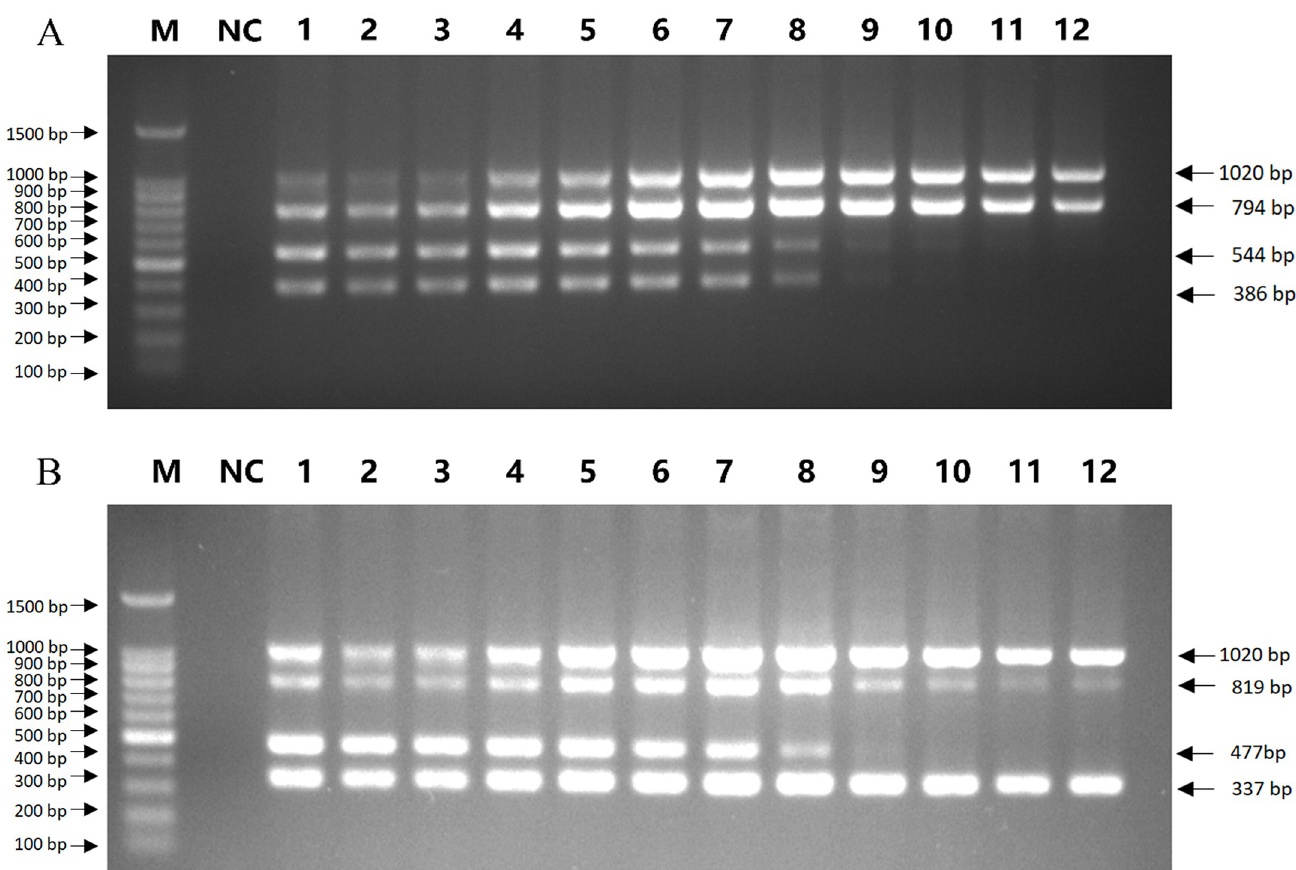
Fig 1. Optimal annealing temperatures in mPCRs. (A) Lane M, 100 bp DNA ladder; Lane NC, negative control for detection of CRV; Lanes 1~12, gradient annealing temperatures were 55.0˚C, 55.5˚C, 56.0˚C, 57.0˚C, 58.2˚C, 59.4˚C, 60.6˚C, 61.8˚C, 63.0˚C, 64.0˚C, 64.5˚C, and 65.0˚C, respectively. (B) Lane M, 100 bp DNA ladder; Lane NC, negative control for detection of CEV; Lanes 1~12, gradient annealing temperatures were 55.0˚C, 55.5˚C, 56.0˚C, 57.0˚C, 58.2˚C, 59.4˚C, 60.6˚C, 61.8˚C, 63.0˚C, 64.0˚C, 64.5˚C, and 65.0˚C, respectively.